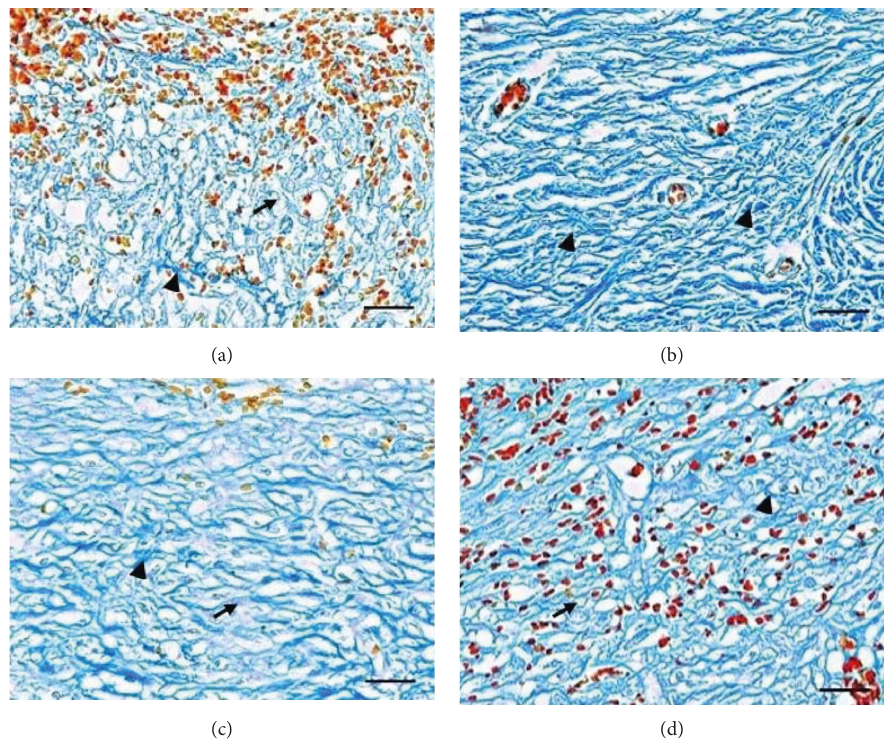
Figure 3: Photomicrographs of collagen deposition in the dermal part of the skin wound healing on day 15. Collagen deposition of group BC with predominant haemorrhage (a); predominantly old collagen deposition in the dermal part of group AV (b); collagen deposition of group AC (c); group SM (d). Note: erythrocytes (orange-red); new collagen fiber (light blue/arrow); old collagen fiber (deep blue/arrow head). Mallory, 400x; scale bar: 50 µ m